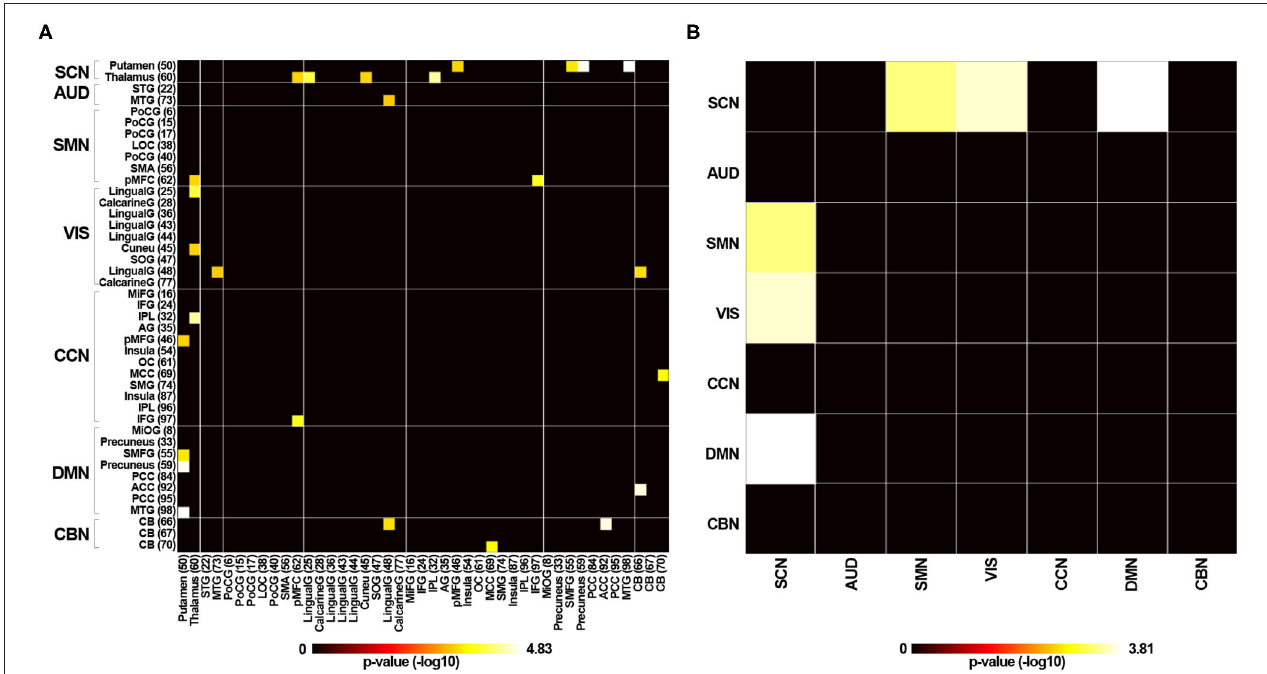
FIGURE 6 | Variability in dynamic functional connectivity across windows. (A) Group difference of connectivity variability of 43 independent components between the RTLE and HC groups ( P < 0.05, FDR corrected). (B) Group difference of connectivity variability of seven functional networks between the RTLE and HC groups ( P < 0.05, FDR